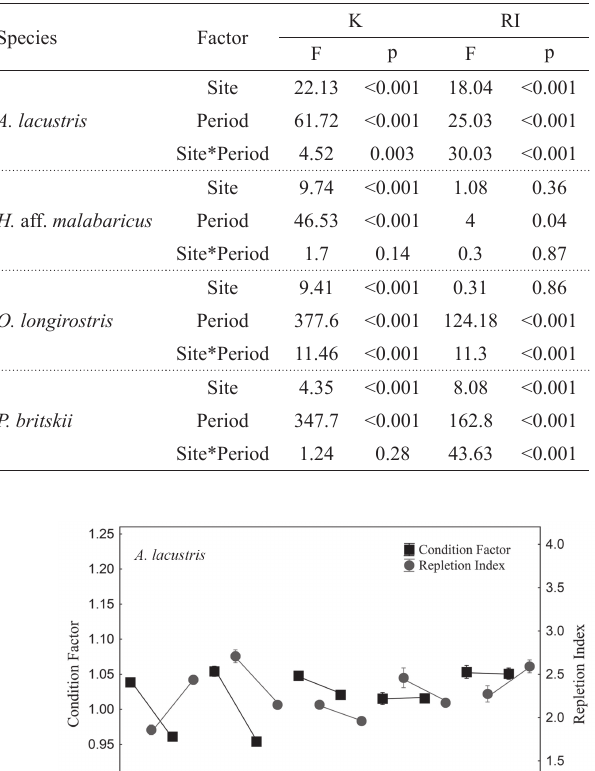
Table 5. Analysis of Variance applied to the condition factor (K) and repletion index (RI) values for sites and periods for the analysed species in the Iguaçu River and its tributaries, in the Salto Caxias Reservoir region.